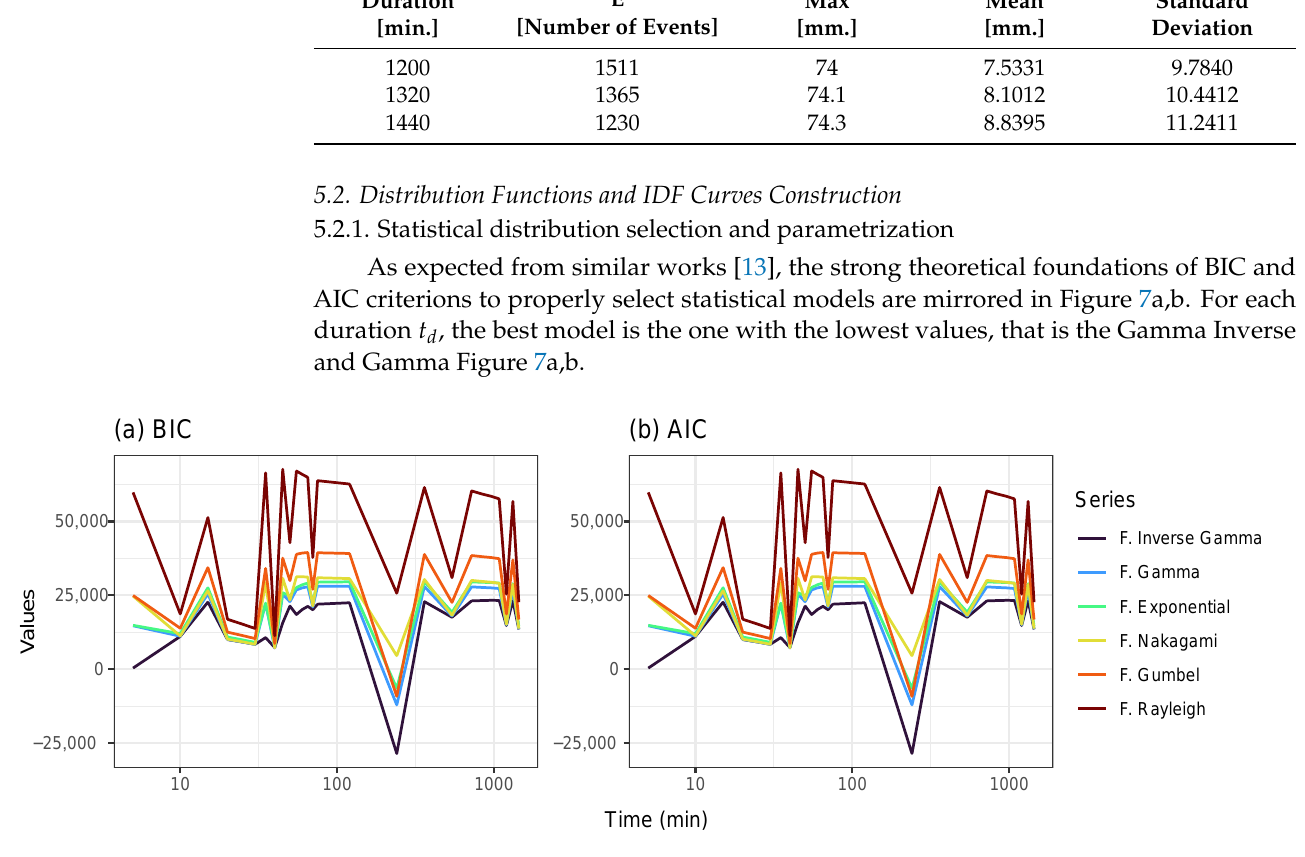
Figure 7. BIC and AIC information criteria of P28-Cruz Loma.